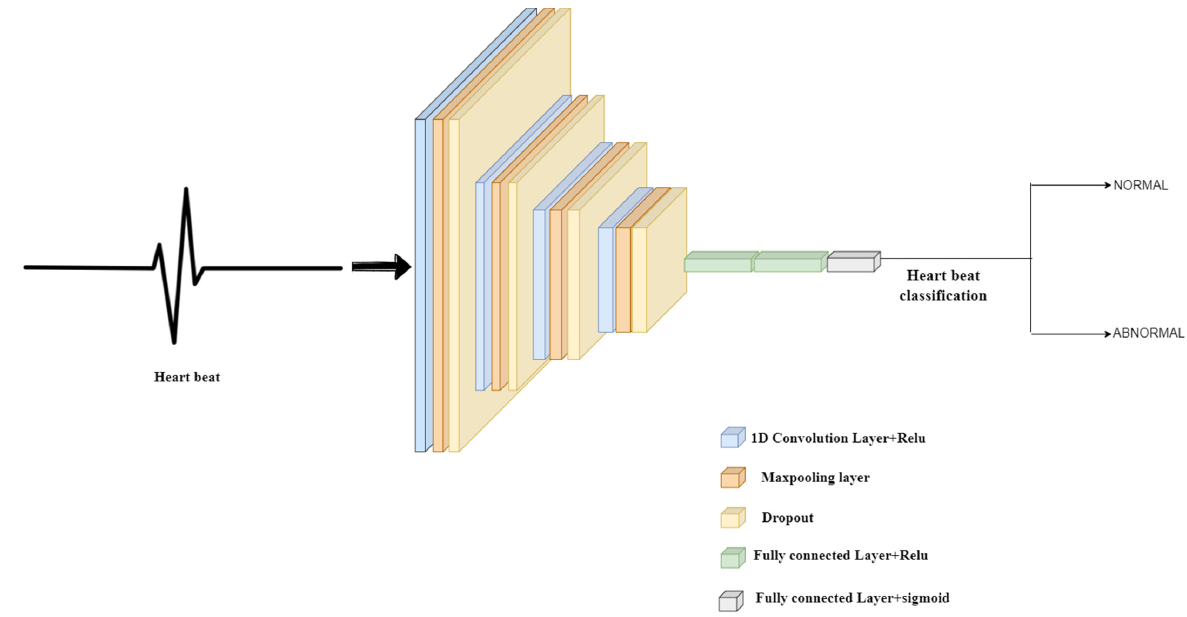
Figure 4. Architecture diagram of Model 3.